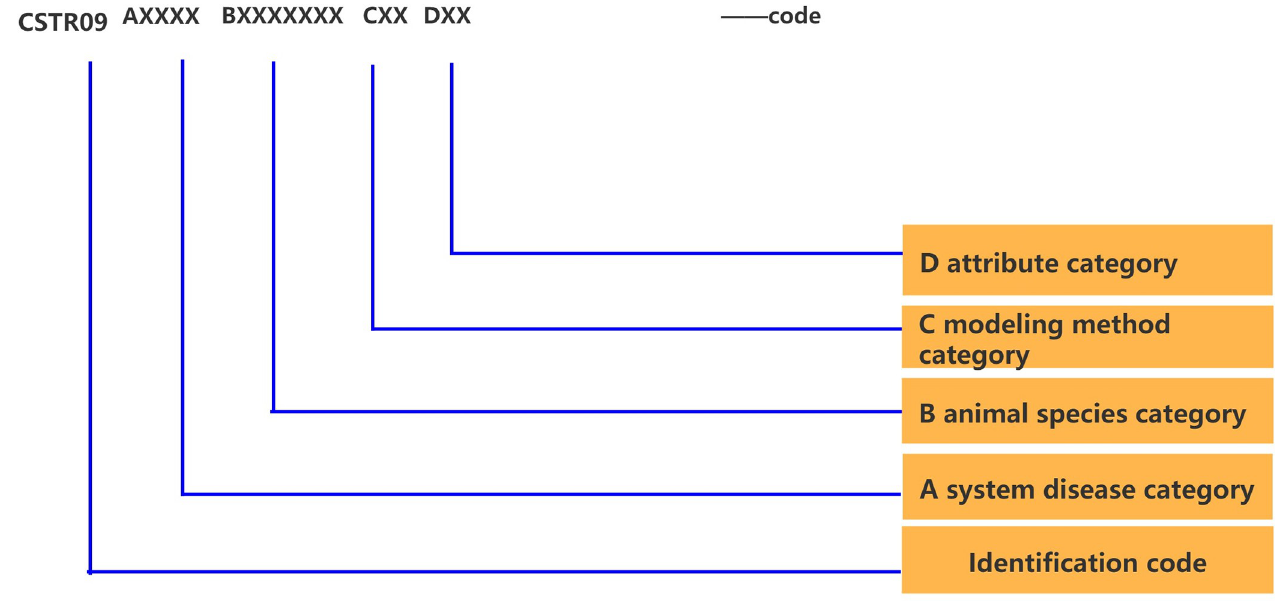
Fig 2. Code structure and